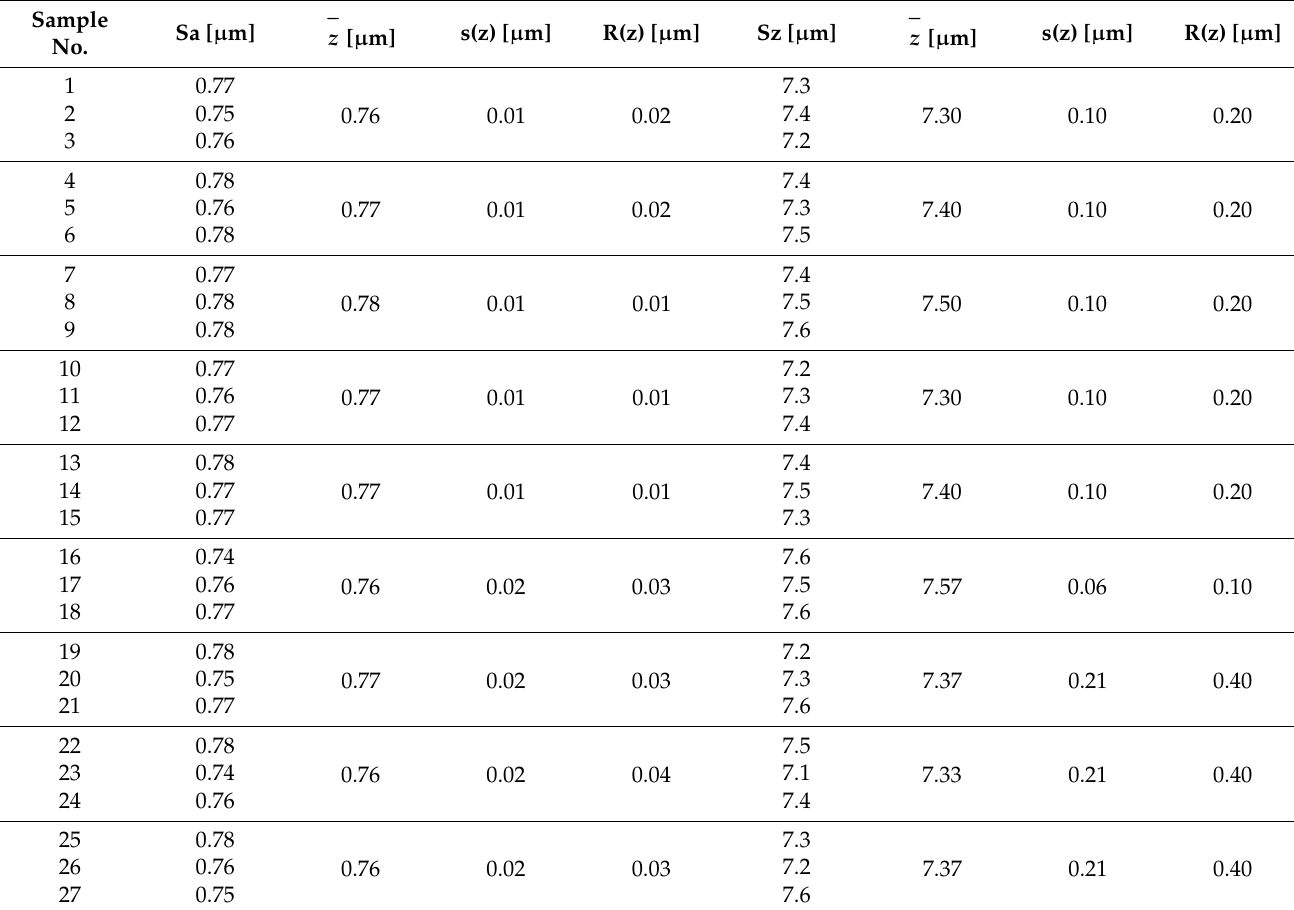
Table 4. Results of Sa and Sz measurements of X5CrNi18-10 steel samples before paint